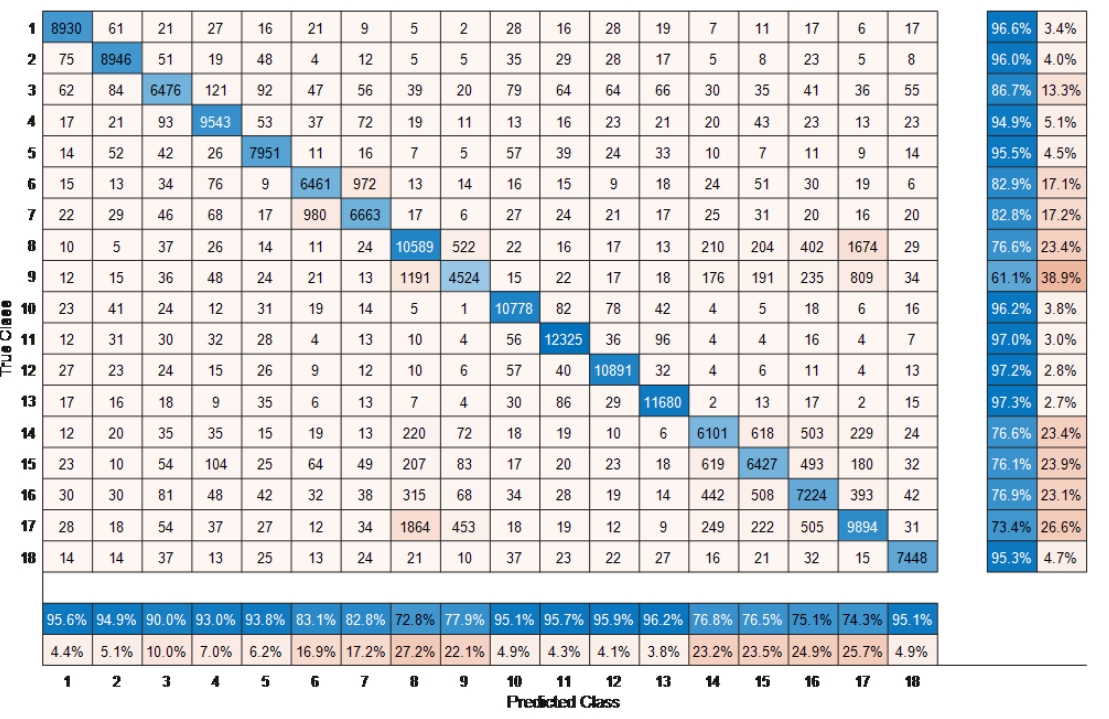
Figure 6. Confusion matrix without EFS technique.